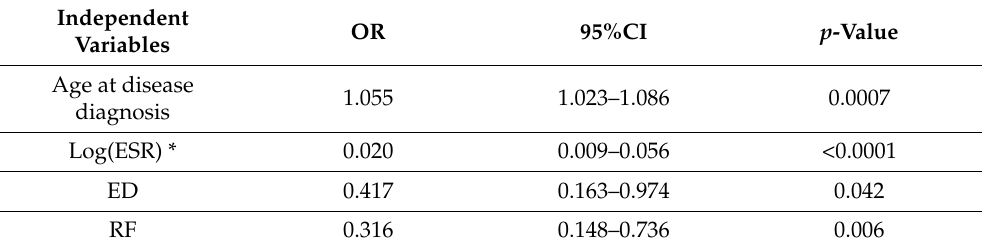
Table 4. Multivariate logistic regression model predicting good response to methotrexate